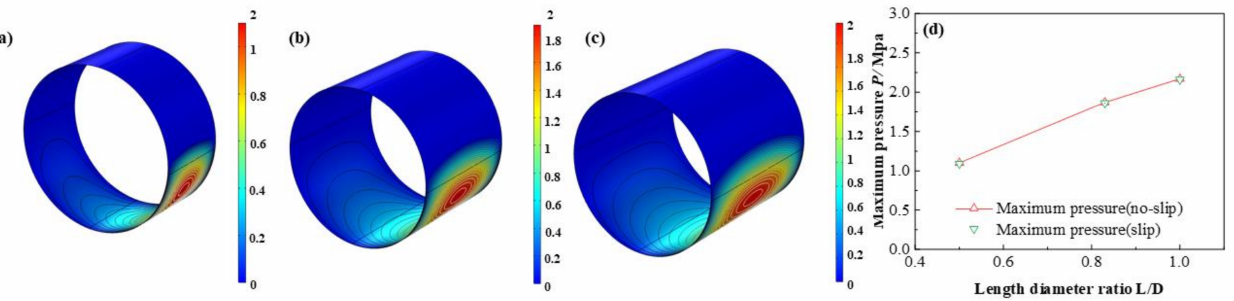
Figure 13. Comparison of the pressure distribution under different length diameter ratios. ( a ) L / D = 0.5; ( b ) L / D = 0.83; ( c ) L / D = 1.0; ( d ) minimum pressure.